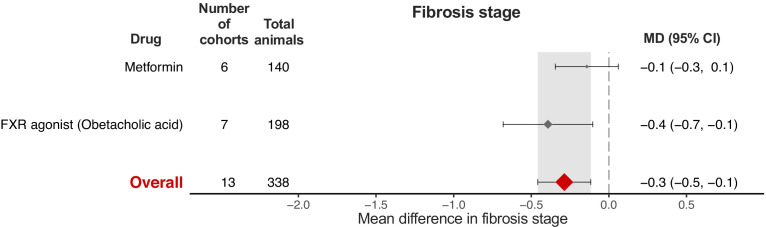
Meta-analysis of fibrosis stage in rodent studies of NAFLD by individual drug.Forest plot with subgrouping by individual drug. Individual studies have been hidden and only subgroup summaries are illustrated. Total animals is the sum of control and interventional animals for each subgroup. CI, confidence interval; FXR, Farnesoid X receptor; MD, mean difference.